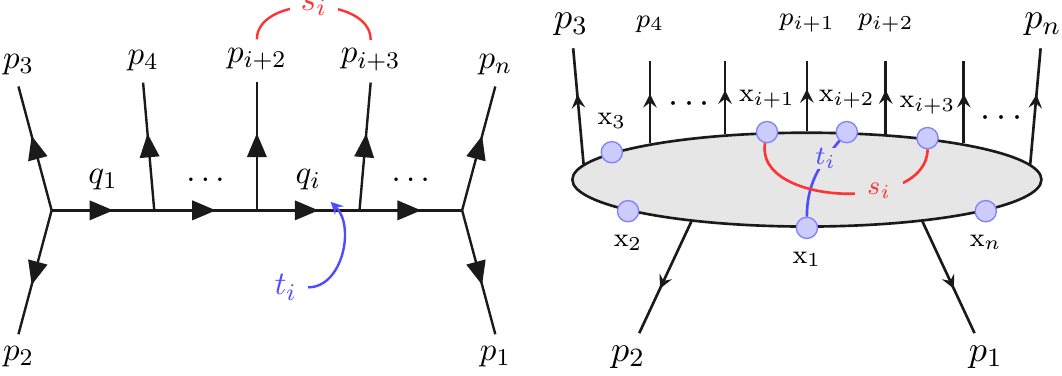
Figure 1 . Graphical representation of the Mandelstam variables s i (2.10) and t i (2.11) in standard momenta (left) and dual momenta (right) using the all-outgoing convention. cross ratios, while u are called small cross ratios. The limit is taken 2 / 3 ,s